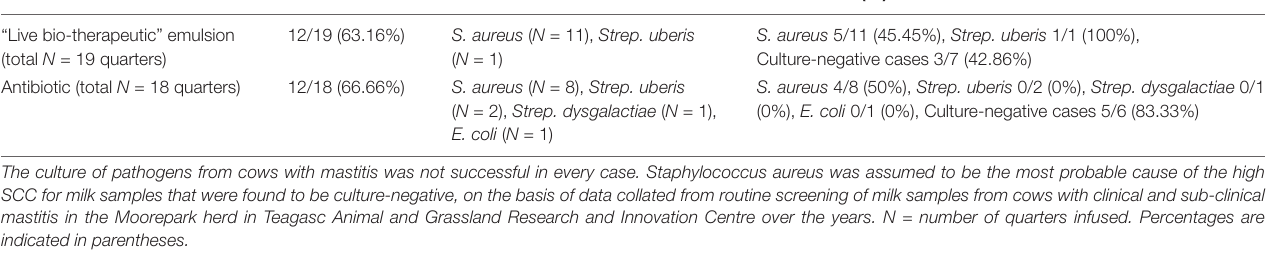
TABLE 1 | Cure rates for cases which gave culture-positive milk samples. Culture-positive Identity of pathogens Cure rate of culture-positive cases based on Treatment